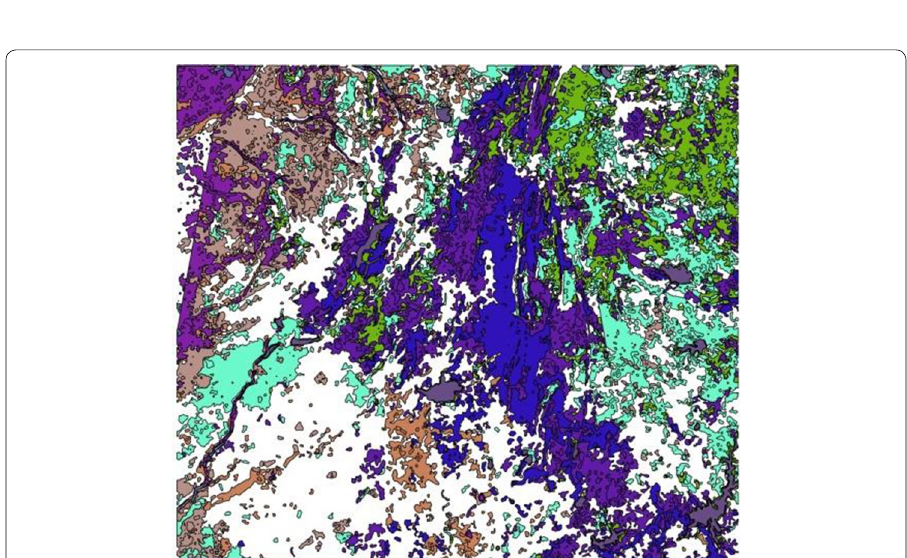
100 pixels and less ×